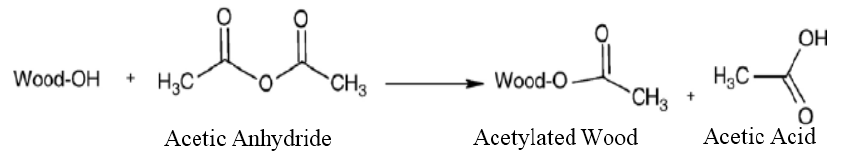
Figure 9. Reaction of wood with acetic anhydride [9].